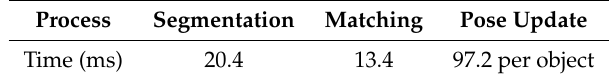
Table 3. Computational time of the each step (ms). Note that the pose of objects is estimated independently, and the overall system takes a time to run if a large number of objects exist in the scene. Process